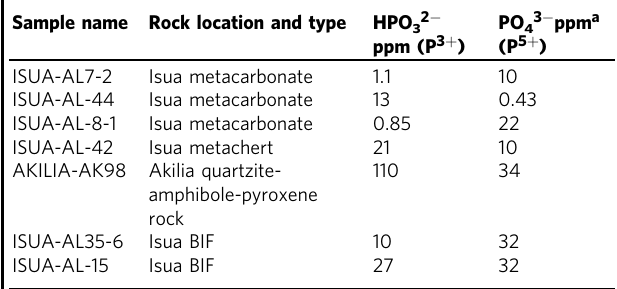
Table 1 Sample site designation, rock types, and